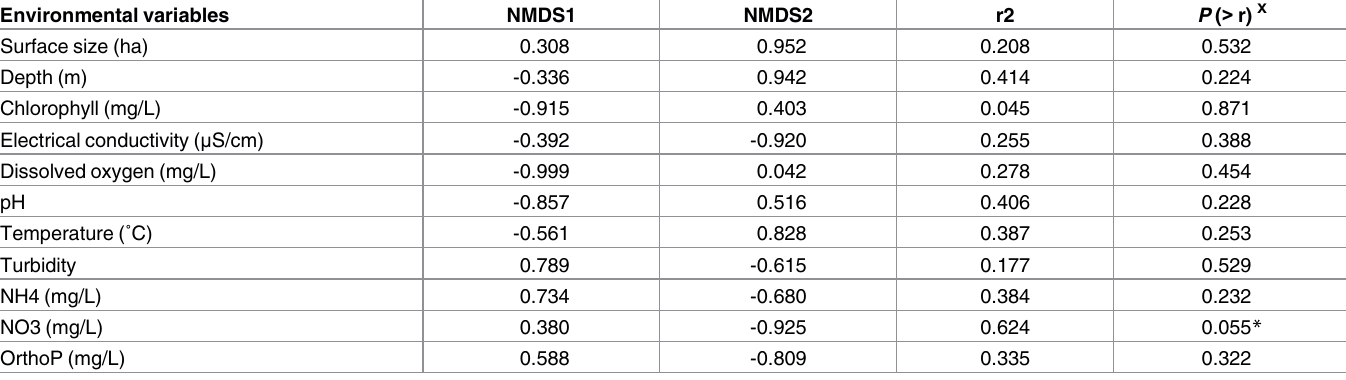
Table 3. Significance of environmental variables in eight reservoirsand an adjacent streamdetermined with permutation tests in fitted Non-metric Multidimensional Scaling (NMDS) ordination (Stress = 0.0698).